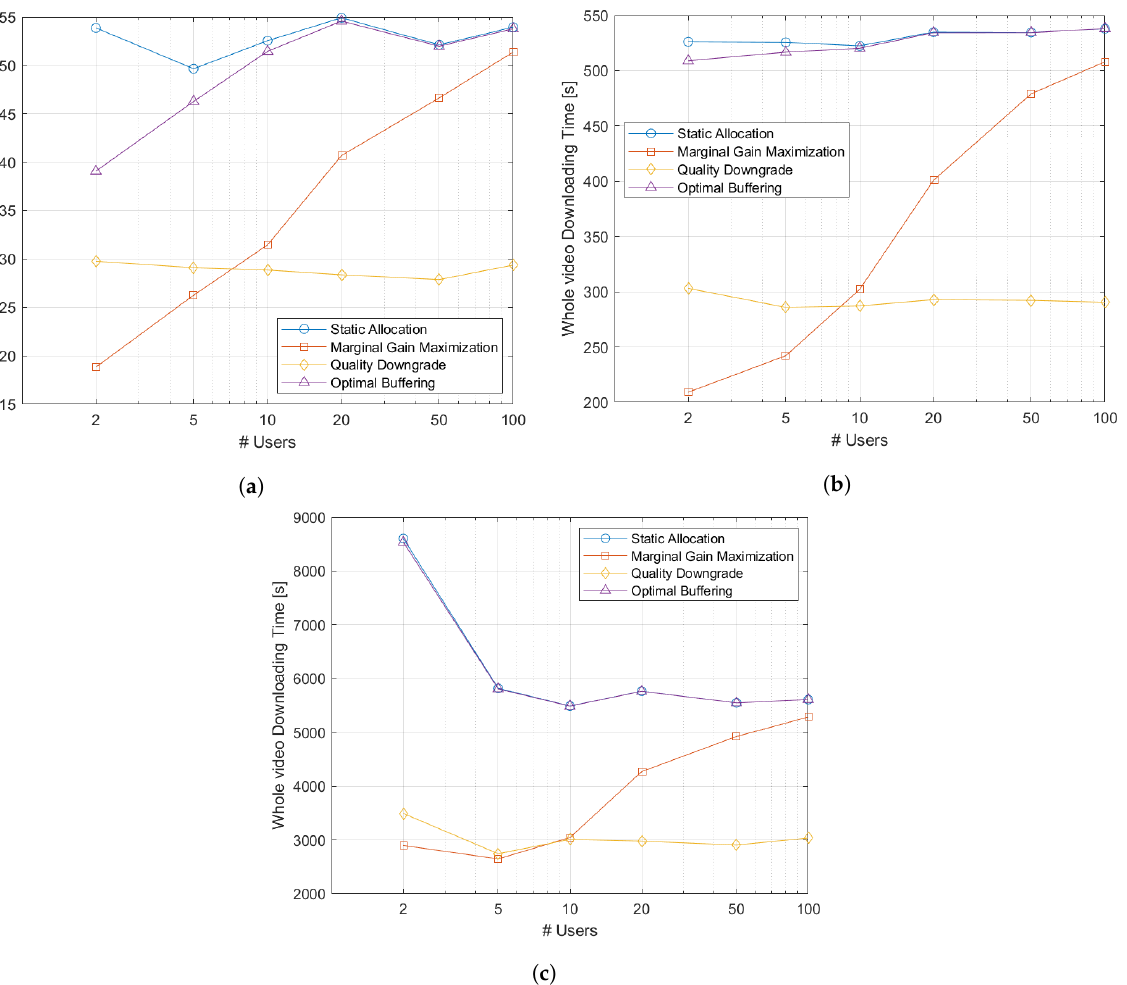
Figure 2. Average video downloading time with variable number of users. ( a ) Short videos. ( b ) Medium videos. ( c ) Long